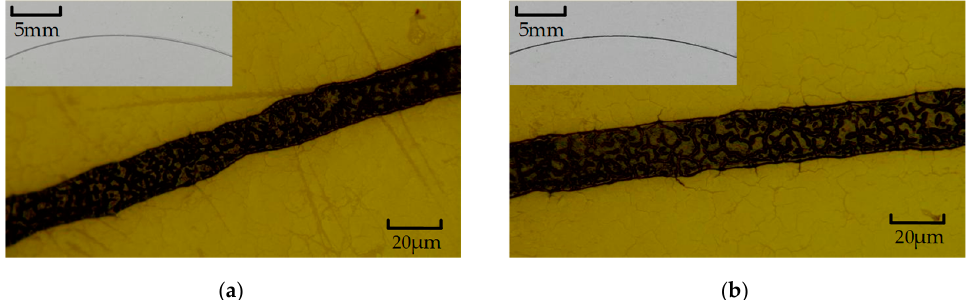
Figure 17. Reducing the speed of motor, using the different voltages to drive the inkjet chip and observe the ink-mark lines. ( a ) The printing path of the inkjet chip when the driving voltage was 10 V. ( b ) The printing path of the inkjet chip when the driving voltage is 12 V.